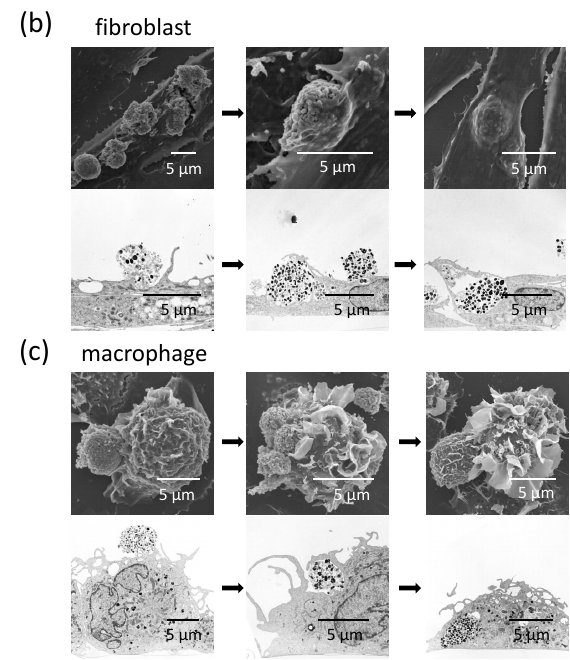
Figure 3. Normal human fibroblasts uptake secreted melanosome clusters as do macrophages. The same amounts of secreted melanosome clusters were added to the culture medium of fibroblasts or macrophages and were incubated for 2 days. ( a ) The upper two light microscopic images show the incorporation of secreted melanosome clusters in fibroblasts (left) and in macrophages (right). The lower photo shows the cell pellets of fibroblasts (left) and macrophages (right) collected from those cells. Sequential SEM images (upper panels) and TEM images (lower panels) of ( b ) fibroblasts and ( c ) macrophages that internalized secreted melanosome clusters are